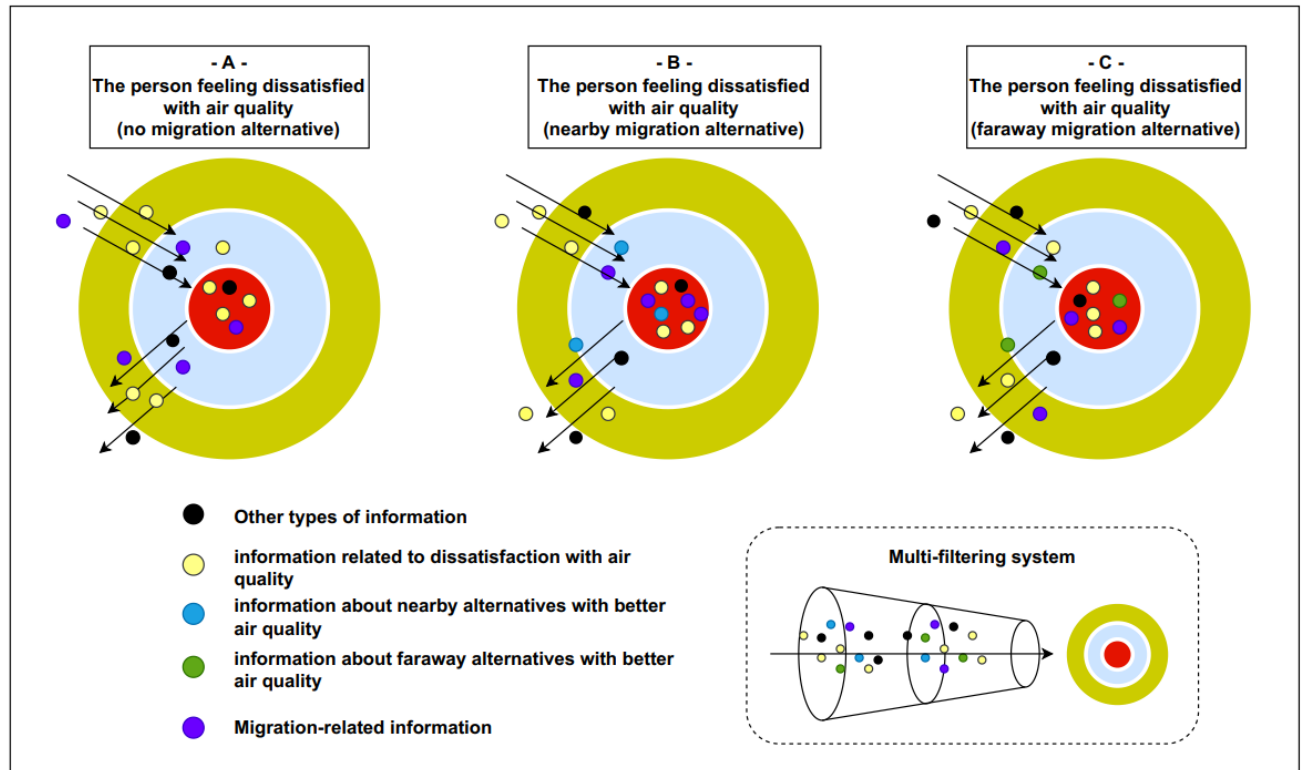
Figure 1. The information-based psychological mechanism leading to the emergence of migration intention.